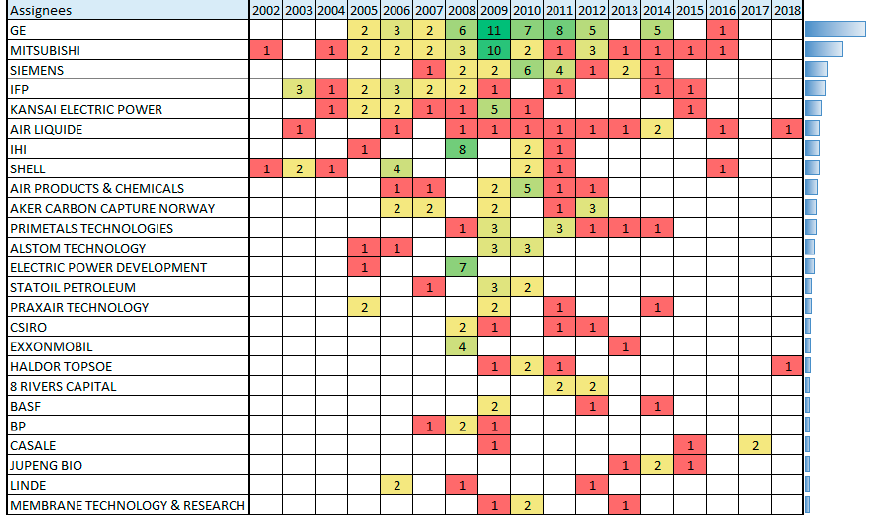
Figure 16. Investment trend for key players. The figure uses two colors to represent high and low numbers i.e., the more green represents high number and more red indicates a lower figure of in- vestment trend each year.